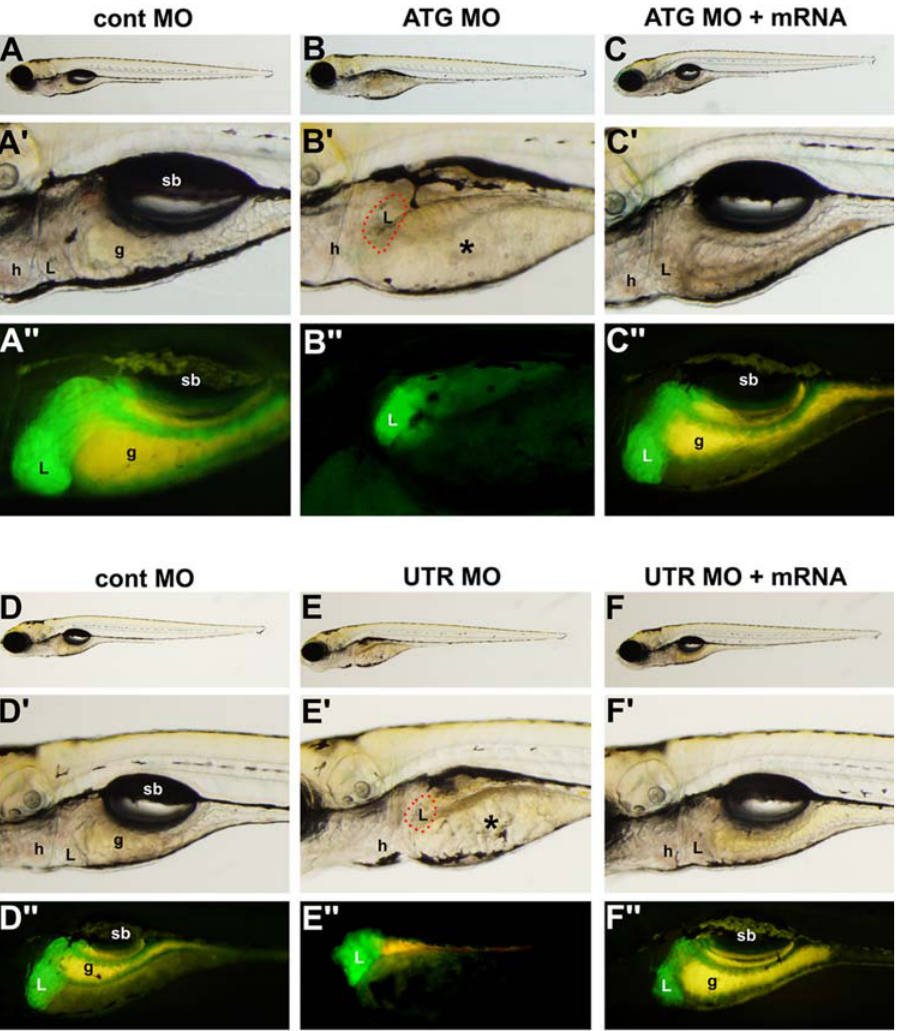
Figure 3. A2ML MOs affect liver formation. Embryos from the ef1a-GFP transgenic line are shown at 5dpf. A–A 0 . cont MO-injected embryos (95% normal, n =30). B–B 0 . A2ML ATG MO-injected embryos showed reduced liver in 90% ( n =45) of cases. C–C 0 Rescue of A2ML ATG MO phenotype by co-injection with A2ML mRNA (80% rescued, n =45). D–D 0 . Cont MO-injected embryos (99% normal, n =35). E–E 0 . A2ML UTR MO injected embryos (98% defect, n =55). F–F 0 . Rescue of A2ML UTR MO phenotype by co-injection with A2ML mRNA (90% rescued, n =47). See Experimental Procedures for injection levels. Red outlines in B 9 and E 9 represent the small livers remaining in these embryos. Asterisks in B 9 and E 9 identify yolk. g, gut; h, heart; L, liver; sb, swim